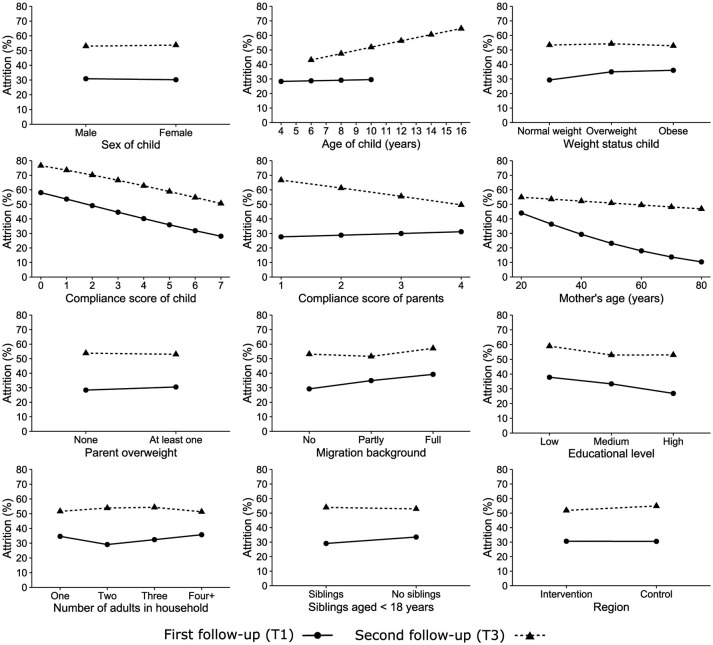
Predicted probabilities of separately modeled interactions of the predictors and time in the random intercept logistic regression. Time variant variables are age of child (years), weight status of child, compliance score of child and of parents, mother's age (years), and parent's overweight.